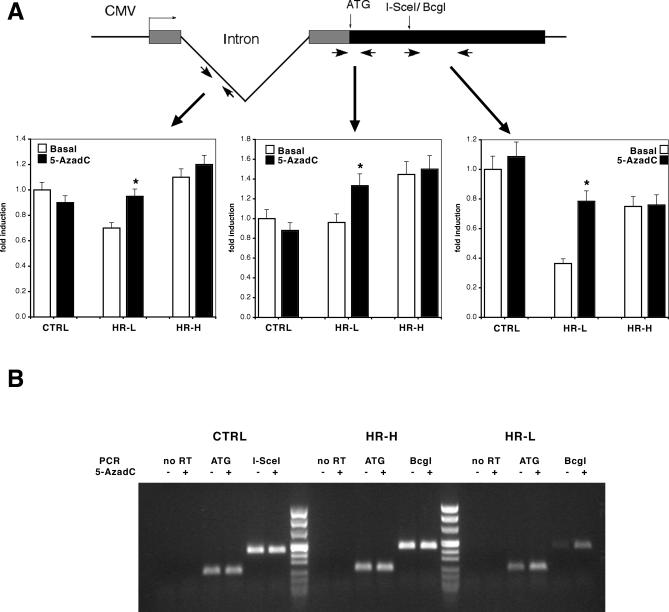
Mapping of GFP Transcription in Recombinant and Nonrecombinant Cells with and without 5-AzadC Treatment(A) A schematic of the DR-GFP transcriptional unit shows the location of the CMV promoter, intron, and GFP coding sequence. Primers used for quantitative RT-PCR and RT-PCR are indicated by arrows. Different sets of primers were derived from the intron (738–757, forward 5′-CGTTACTCCCACAGGTGAGC-3′; 966–948, reverse 5′-CGCCCGTAGCGCTCACAGC-3′), AUG (1,666–1,685, forward 5′-TACAGCTCCTGGGCAACGTG-3′; 1,911–1,892, reverse, 5′-TCCTGCTCCTGGGCTTCTCG-3′), and BcgI/I-SceI (described in Figure 1A) segments of GFP gene.Control (DR-GFP cells transfected with pBluescript), HR-L, and HR-H cells were treated with 40 μM 5-AzadC for 48 h. Total RNA was extracted 24 h later and subjected to quantitative RT-PCR with the primers indicated. The data, derived from three independent cDNAs, are shown as fold induction by 5-AzadC over the basal control, normalized to GADPH and β-actin. The primers used to amplify the control samples were those indicated as I-SceI unrec (Figure 1A).(B) Shown is RT-PCR with the same cDNAs indicated in (A) at 30 cycles.